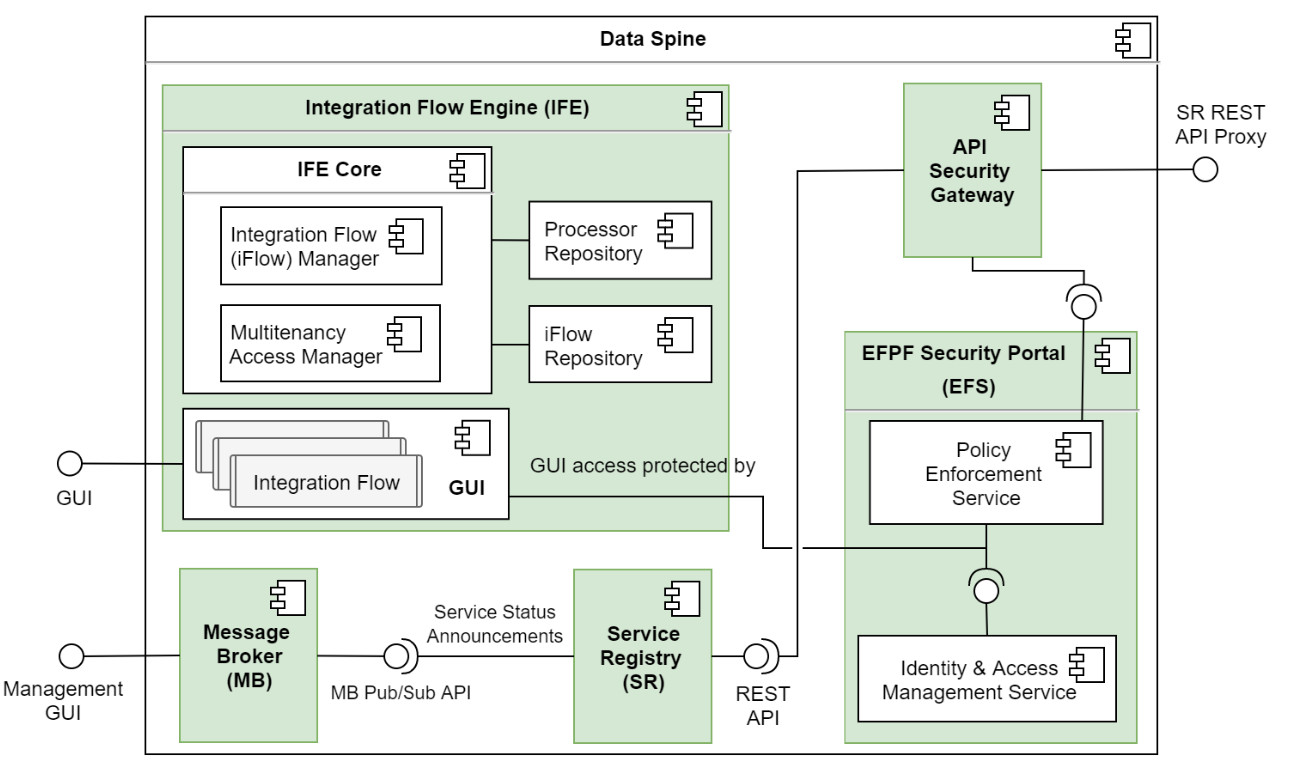
Figure 5. Detailed architecture of the Data Spine.